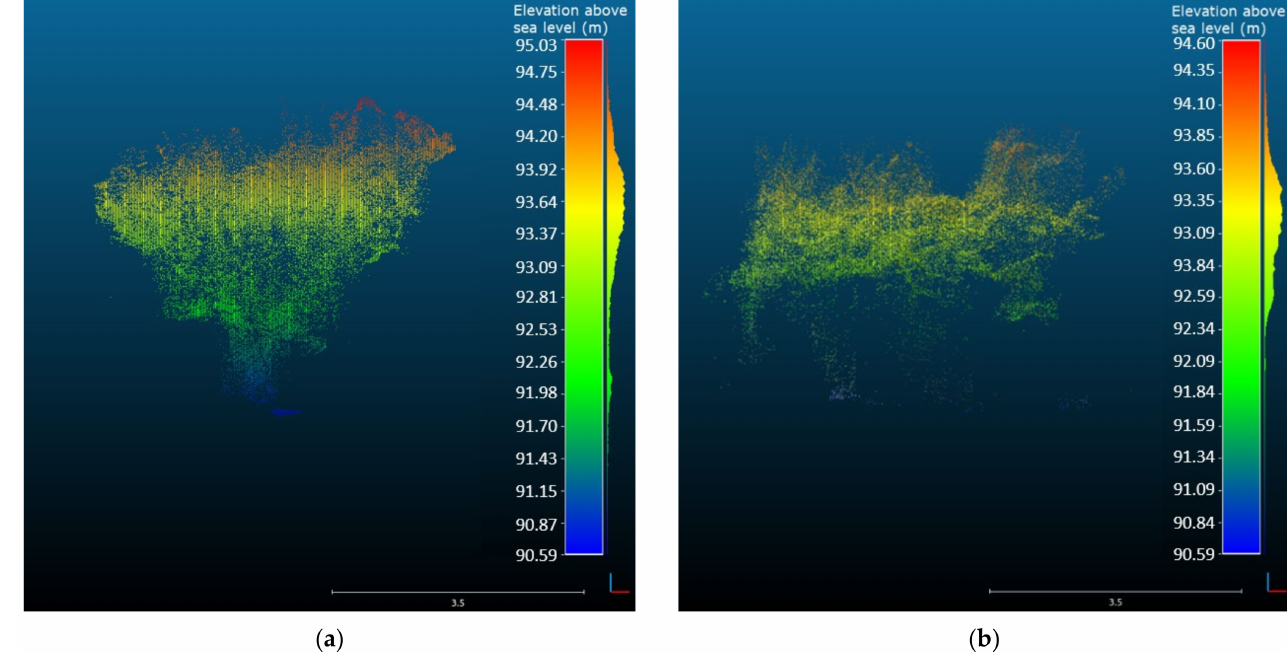
Figure 6. The side view of the georeferenced 3D point cloud of a sample tree captured by the ground- based system using the ZED camera ( a ) and by the UAV aerial-based system ( b ), used to estimate the tree